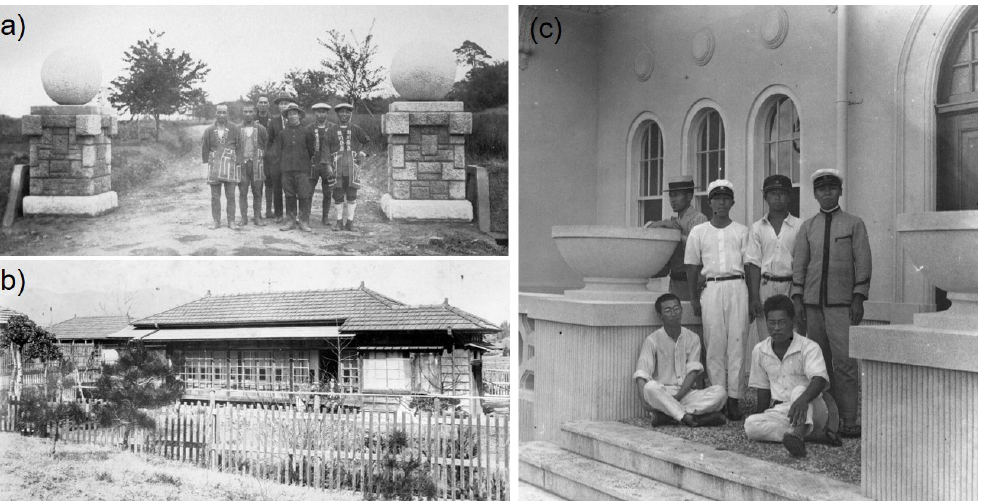
Figure 9. (a) The main gate of the observatory at its completion with the craftsmen. The two spherical boulders on the top represent the Earth. (b) Houses for the staff of Kakioka Magnetic Observatory. (c) The observatory staff in August 1925. The newly staffed observatory started with three staff members in 1924, and the staff number gradually increased (photo supplied by Kakioka Magnetic